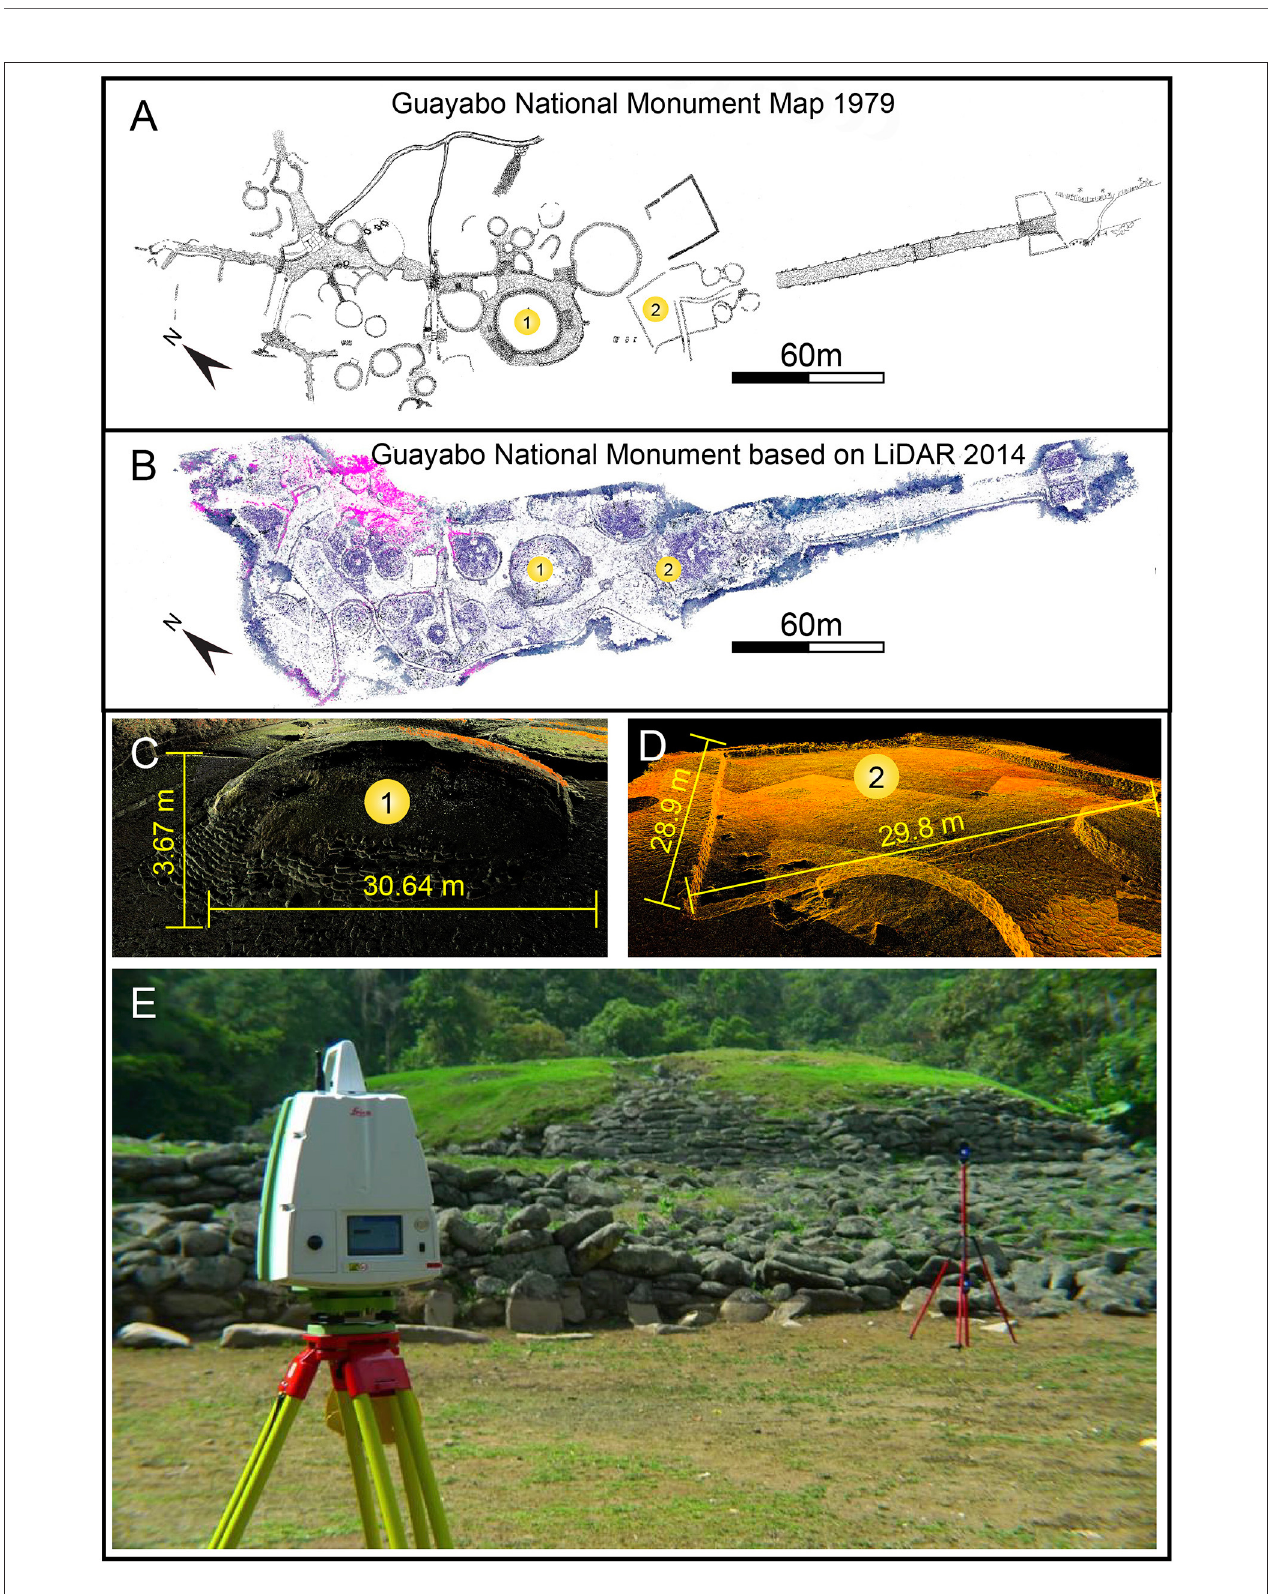
FIGURE 7 | (A) Guayabo map from Fonseca (1979) based on conventional topography survey; (B) Guayabo map based on LiDAR data collected in 2014 by LANAMME-UCR; (C) Main circular basement of Guayabo LiDAR image; (D) Main square LiDAR image; (E) In the foreground the Leica LiDAR Scanner C10 used to obtain the data above. The flat area in the middle corresponds to the main square and in the background of the picture, the main basement is visible.